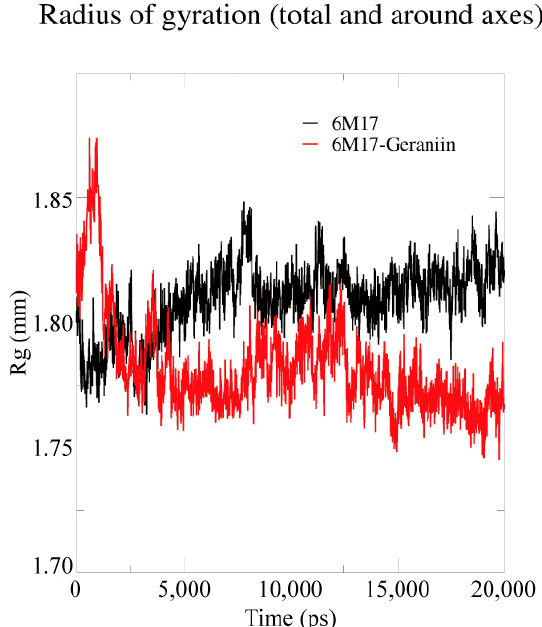
Figure 5. Backbone RMSFs of the apo 6M17 and 6M17–geraniin complex structures. The black and red lines indicate the comparison of the apo 6M17 and 6M17–geraniin complex, respectively. The x and y axes indicate the residue numbers and the mobility in nm, respectively. (RMSF—Root Mean Square Fluctuation).